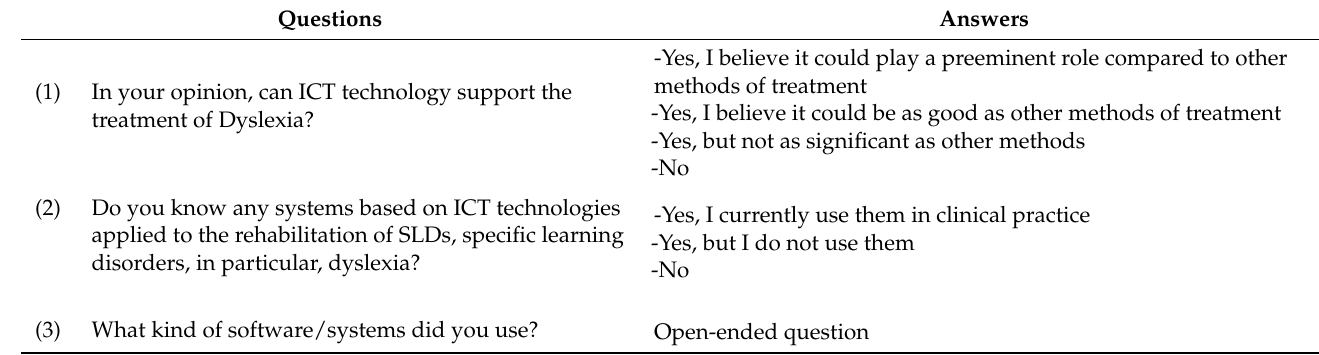
Table 1. Round 1 questions and response